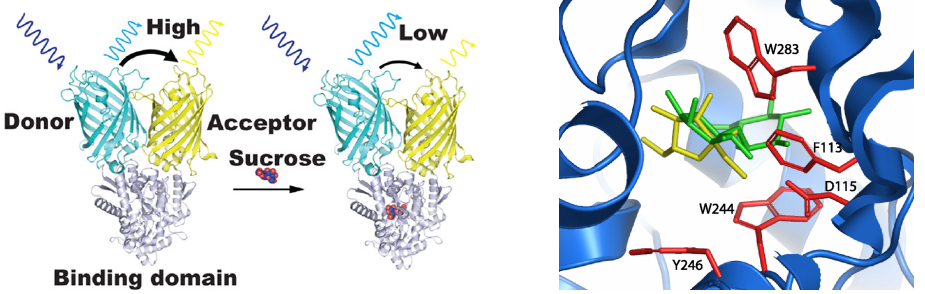
Figure 8. ( Left ) Model representation for the FLIPsuc- ∆ 1 eCFP − eYFP sensor in free form and bonded to sucrose [90]. Sucrose binding triggers conformational rearrange of sugar-binding protein, quenching the emission fluorescence from the FRET process [14]. ( Right ) Close-up view of the carbohydrate binding site in FLIPsuc- ∆ 1 eCFP − eYFP chimeric protein. In red are the residues key for carbohydrate binding, yellow is for the sucrose representation, and green is for maltose representation. Left figure taken from the reference [14], and the right panel figure taken from the reference